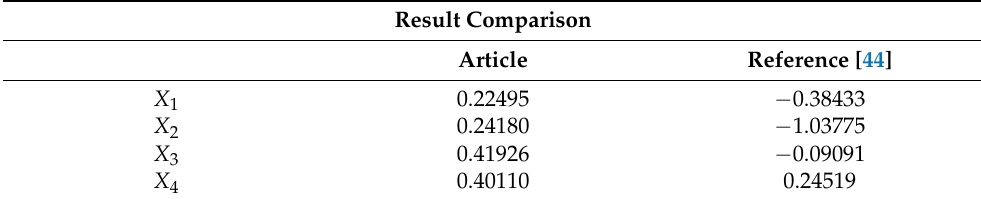
Table 6. Result comparison of different decision-making